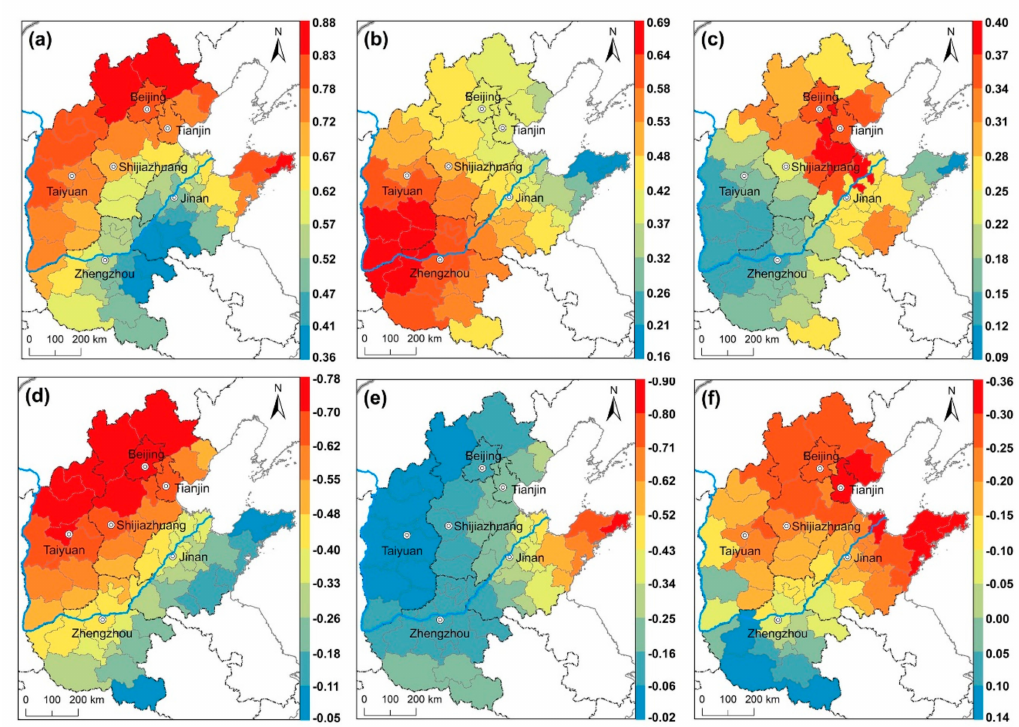
Figure 11. Results of the geographically weighted regression (GWR) in 58 cities. ( a ) Local R 2 of GWR. ( b ) Local coe ffi cients of civil vehicle number. ( c ) Local coe ffi cients of industrial structure. ( d ) Local coe ffi cients of wind speed. ( e ) Local coe ffi cients of forest coverage. ( f ) Local coe ffi cients of per capita gross domestic product